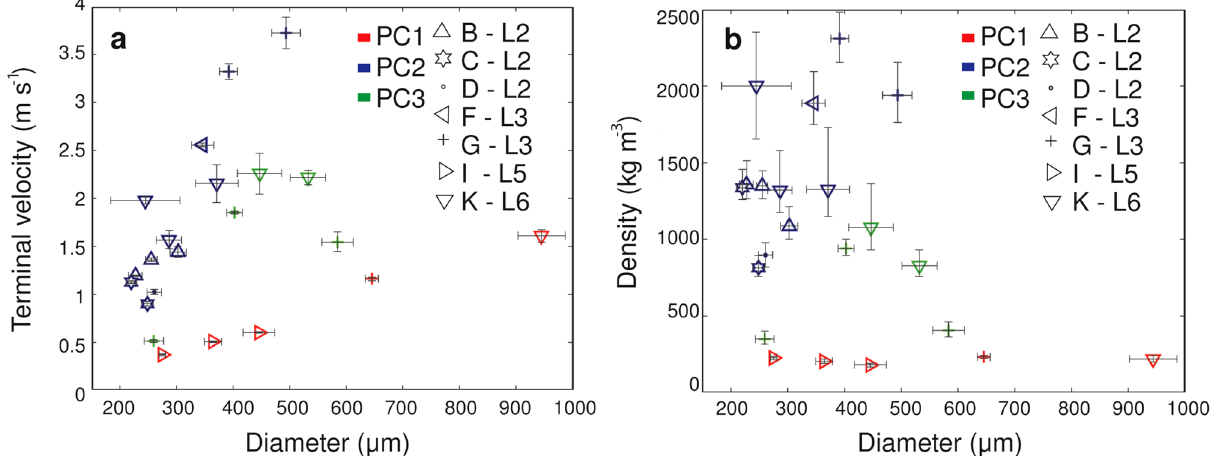
Figure 3. Aerodynamic properties of aggregates (PC1s in red, PC2s in blue and PC3s in green) analyzed with the HSC videos. ( a ) Terminal velocity versus size and ( b ) aggregate density versus